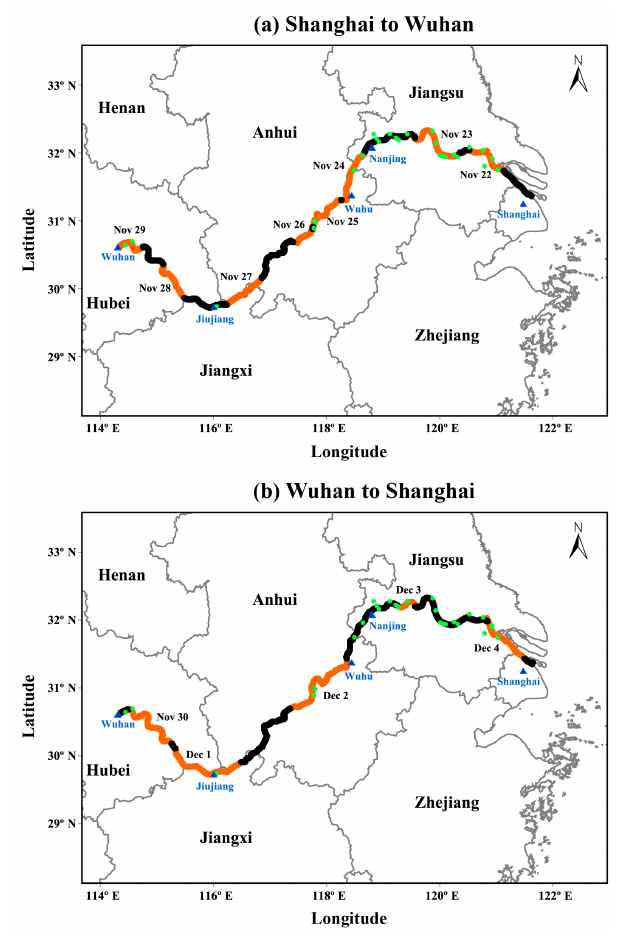
Figure 1. The ship tracks of (a) the departing journey (from Shang- hai to Wuhan) and (b) the returning journey (from Wuhan to Shang- hai). The sections of the cruise track highlighted in orange indicate the period of MAX-DOAS observations. The green dots represent the major power plants along the Yangtze